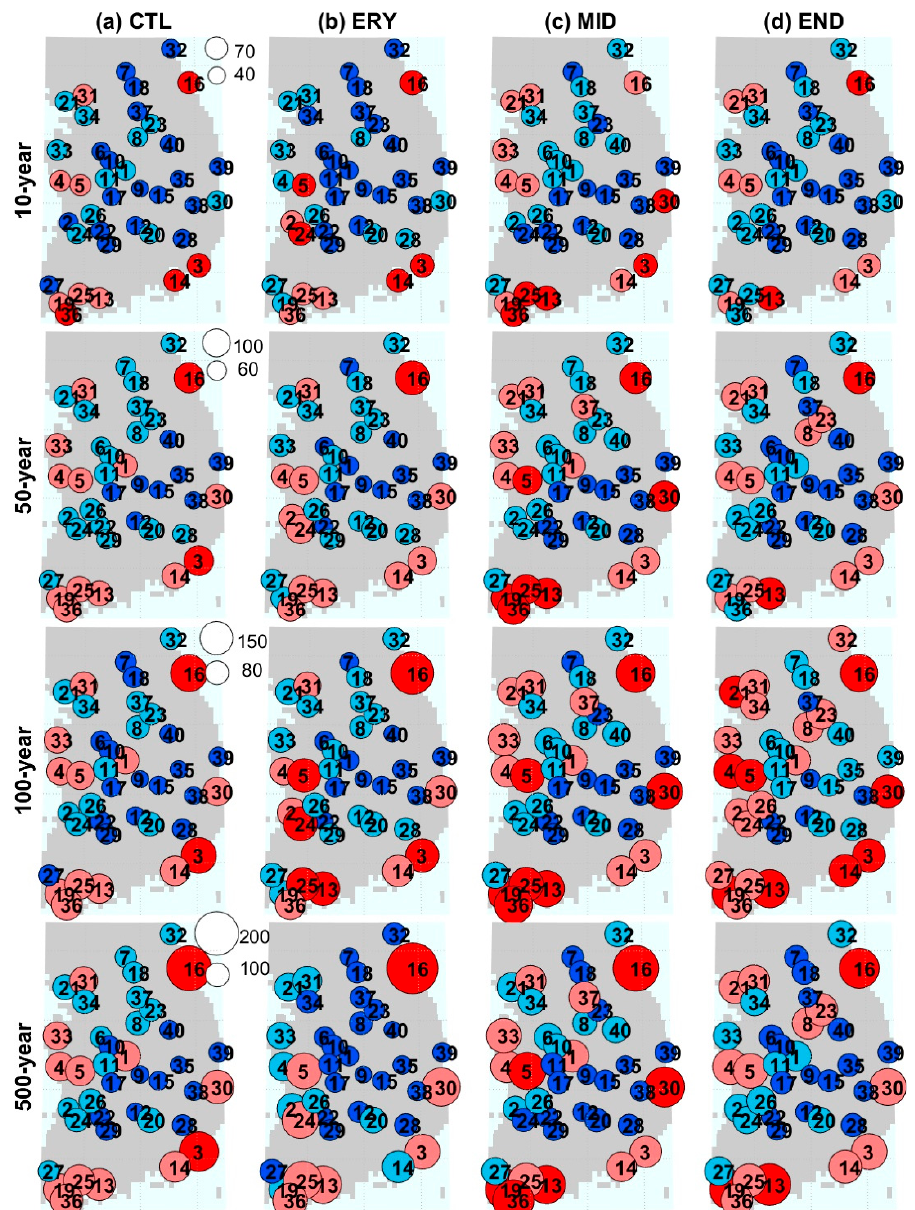
Figure 4. Spatial distribution of rainfall frequency estimates over South Korea for the control (CTL) and 3 future periods (ERY, MID, END) with the RCP 8.5 for the 10-, 50-, 100-, and 500-year return periods and 1-h duration. Four clusters from blue (as the smallest cluster), light blue, light red to red (as the largest) are identified after applying the k -means algorithm. The number near white circles is the legend to show the relative magnitude of rainfall estimates.